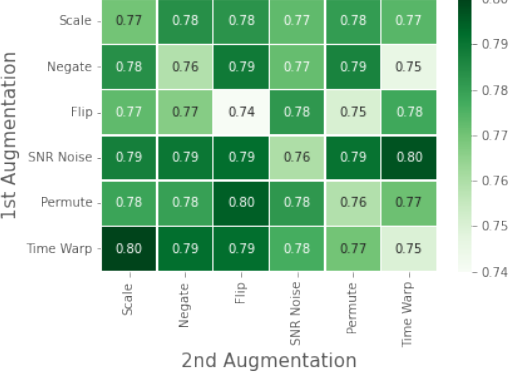
Figure 5. Contrastive SSL evaluation of WESAD under single or composition of data augmenta- tions. Diagonal values correspond to single augmentations, while off-diagonals correspond to the composition of two augmentations applied